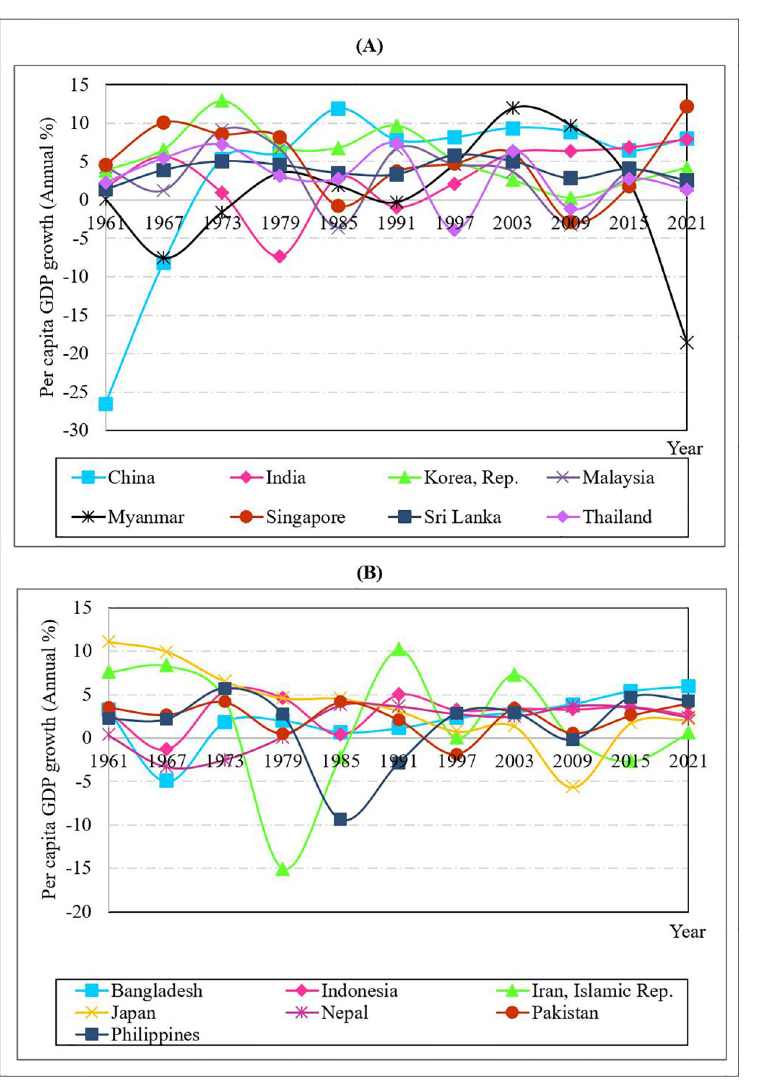
Fig 1. Per capita GDP growth (annual percentage): A comparison. Source: WDI